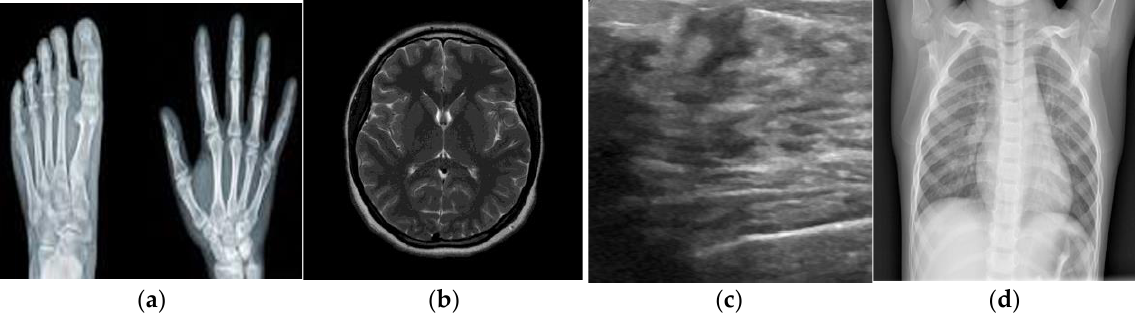
Figure 8. (a) Palm X-ray; (b) brain tumor; ( c ) ultrasound; (d) chest X-ray.